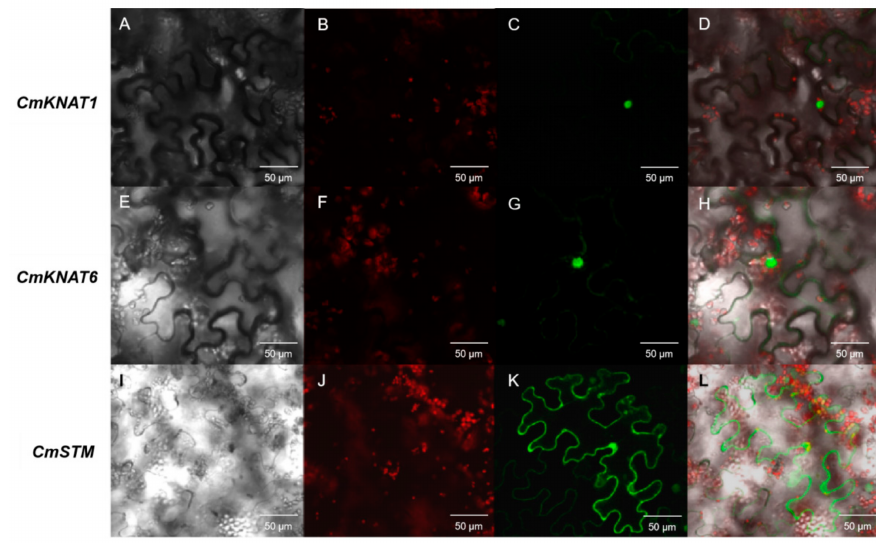
Figure 4. Subcellular localization of these three chrysanthemum KNOX genes in Nicotiana benthamiana leaves (( A , E , I ) show the cells under bright field; ( B , F , J ) show the spontaneous red light of chloroplasts; ( C , G , K ) show the green fluorescence of GFP protein; ( D , H , L ) show the superposition of bright field and fluorescence).